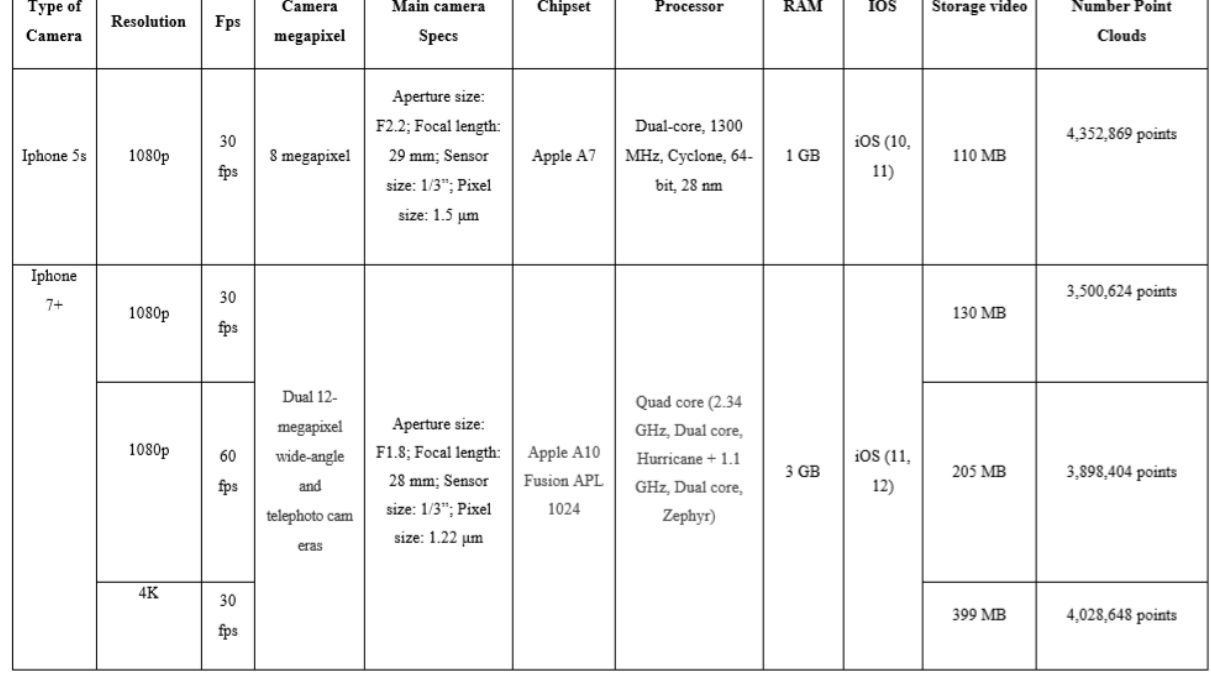
Figure 6. Other camera